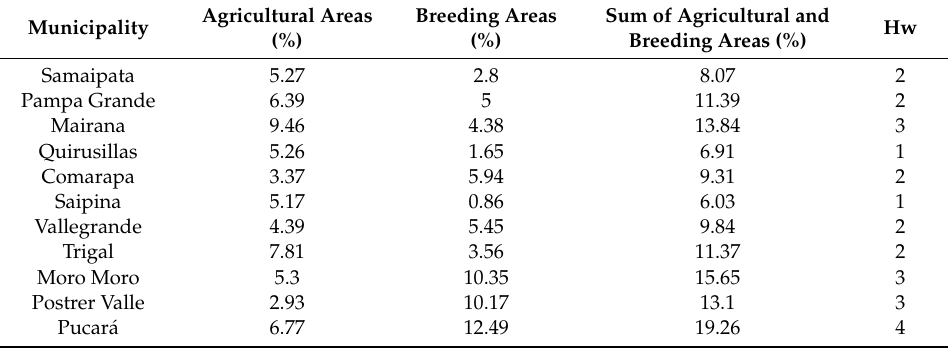
Table 15. Classification of water pollution hazard (Hw) value, Hw varies from 1 (lower) to 4 (higher).